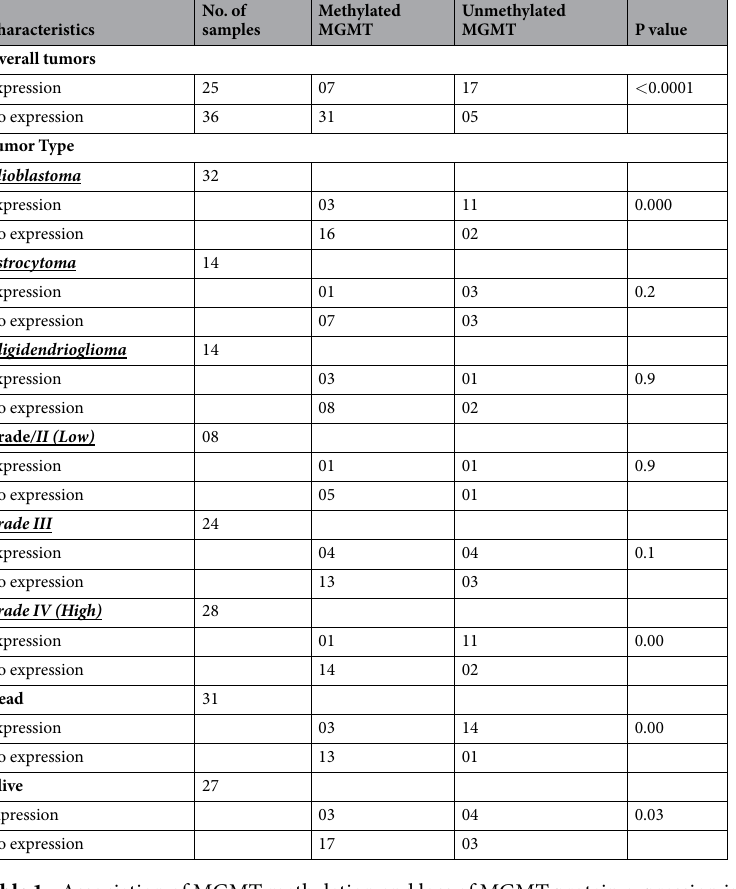
TMZ therapy and radiotherapy as depicted in Table 3. Again by multivariate Cox regression model (Table 4), correlation was evaluated between the status of TMZ therapy and MGMT parameters (methylation and its expression), with other characteristics taken into consid- eration including age at first contact, and gender. TMZ therapy had a significant impact on glioma patients with MGMT promoter methylation with a HR of 0.76 (0.21–2.899; p = 0.029) as compared to 3.78 HR (95%; 1.71–6.8); Table 4. Similarly, lack of MGMT protein expression showed significant concordance along with methylation pattern when correlated with TMZ therapy (HR = 2.02 (95% C.I; 2.00–5.847; p = 0.04). Discussion